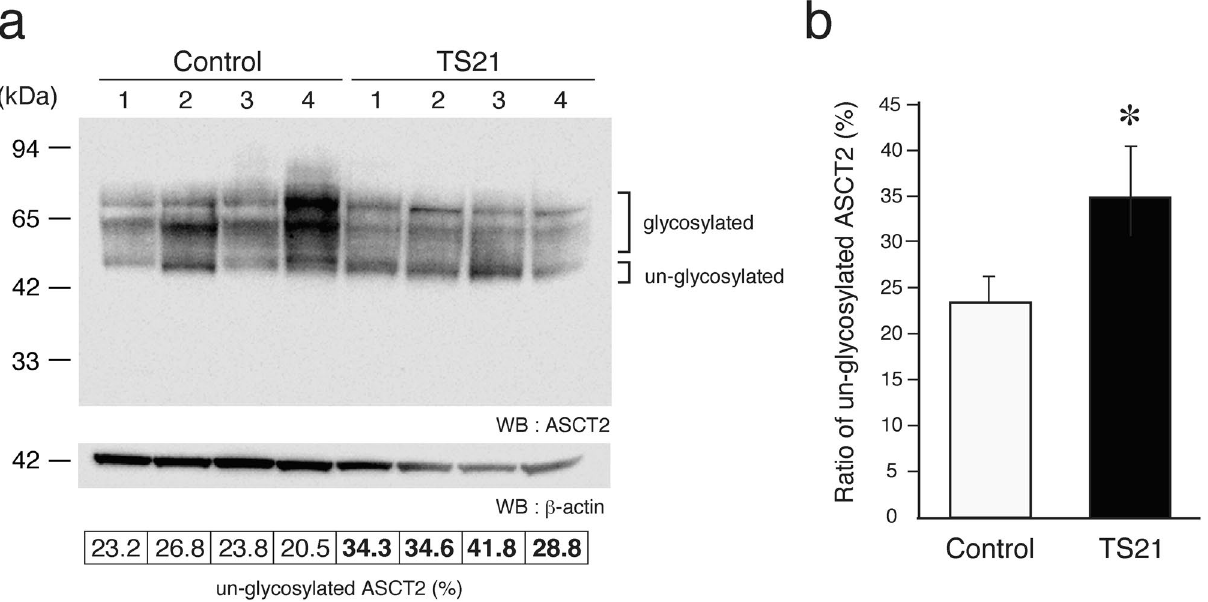
Figure 3. Association between SUPYN and ASCT2 induces glycosylation changes in TS21 placentas. ( a ) ASCT2 western blot analysis using gestational age-matched disomic control and TS21 placental samples. The numbers 1–4 represent sample replicates. Quantitative analysis of the percentage of ASCT2 in un-glycosylated bands when compared to total ASCT2 is presented at the bottom of the diagram. Glycosylated and un-glycosylated ASCT2 band intensities were quantified using CS analysis software from ATTO (2110030, Tokyo, JAPAN). The un-glycosylated ASCT2 ratio (%) represents the un-glycosylated band intensity / total band intensity × 100. ( b ) Average ratios combining all 4 replicates are graphically depicted. Statistical analysis was performed using the Mann Whitney U test. Statistical significance was set at * : p < 0.05. Values represent mean ± SD (n =